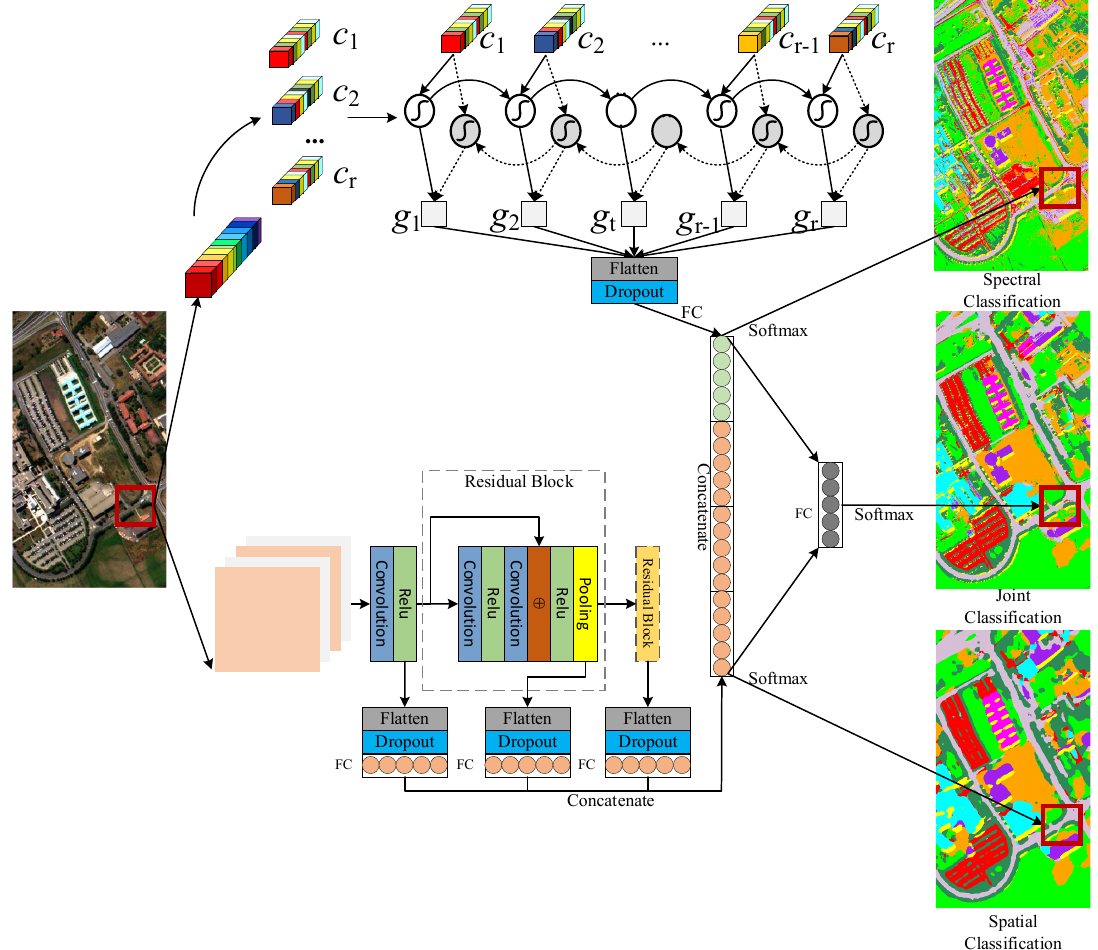
Figure 3 . Architecture of the proposed